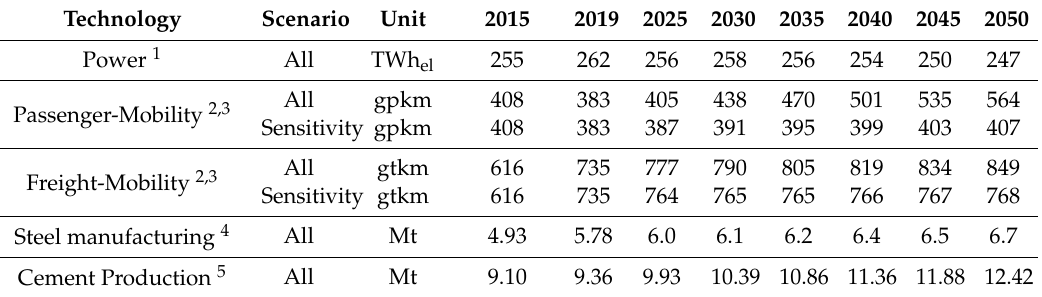
Table A16. Sector-specific demands represented for total Australia. Data based on Reference [7,18,57,59,72,